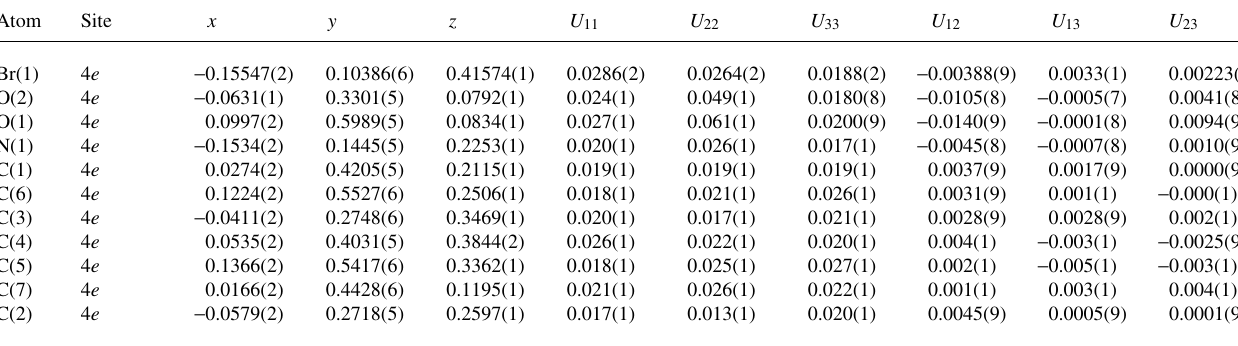
Table 3. Atomic coordinates and displacement parameters (in Å 2 )